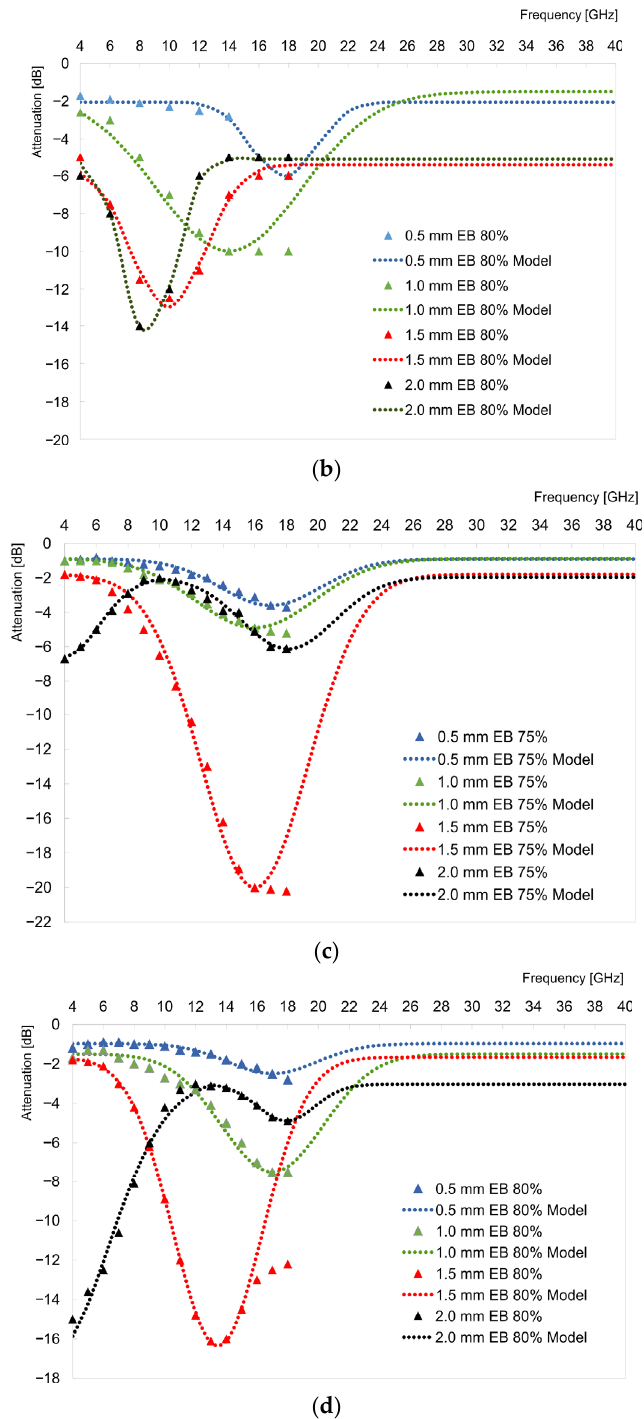
Figure 3. Visualization of results from measurements and modeling for resin L1 and 75% absorber content ( a ), resin L1 and 80% absorber content ( b ), resin L2 and 75% absorber content ( c ), and resin L1 and 80% absorber content ( d